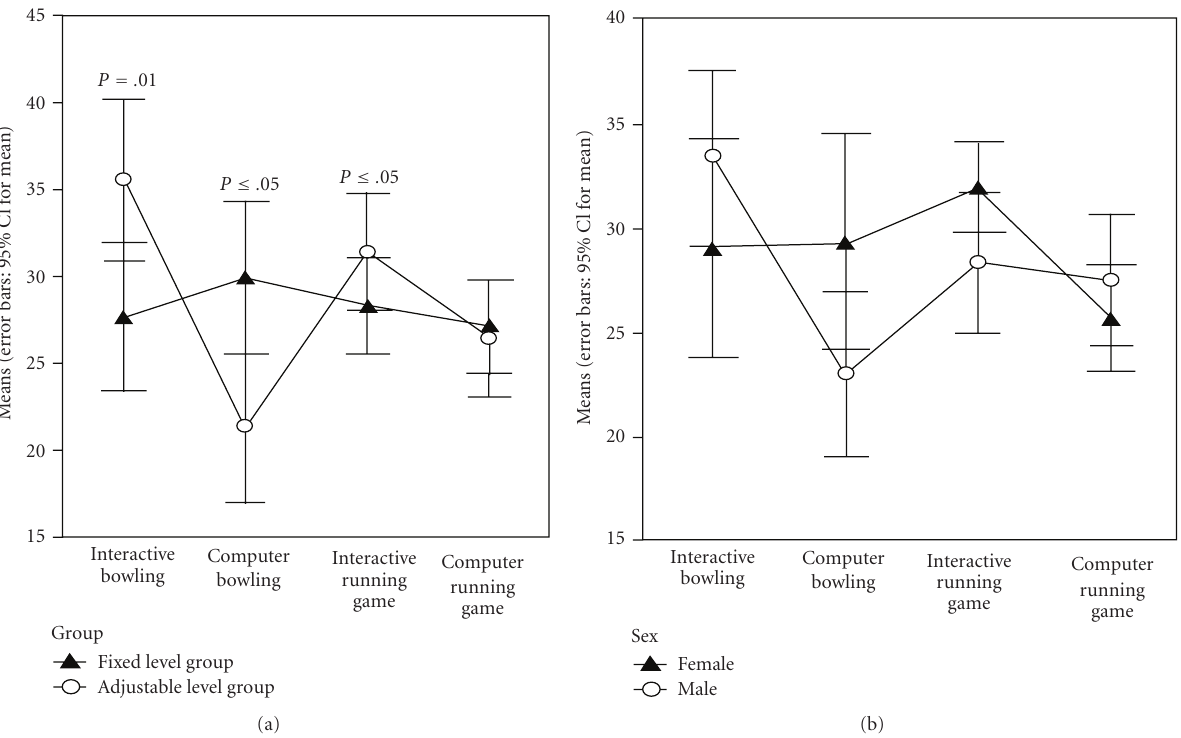
Figure 1: Mean minutes spent by game type and mode, after adjusting for